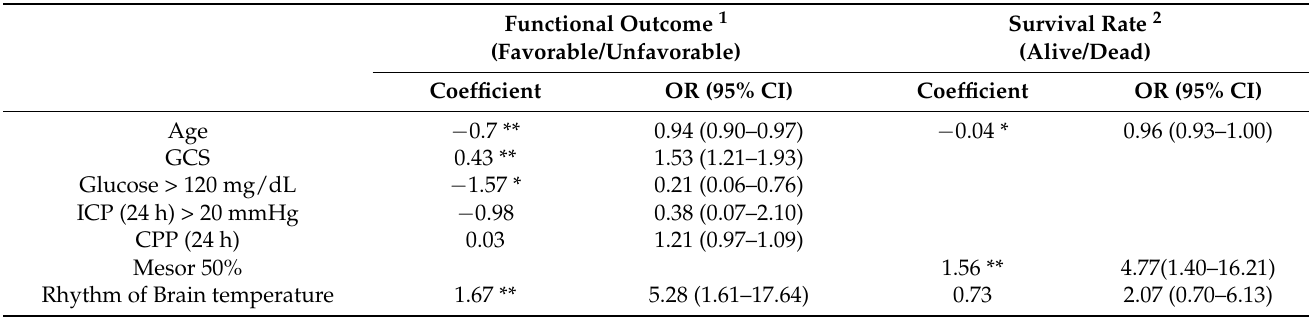
Table 4. Multivariate logistic